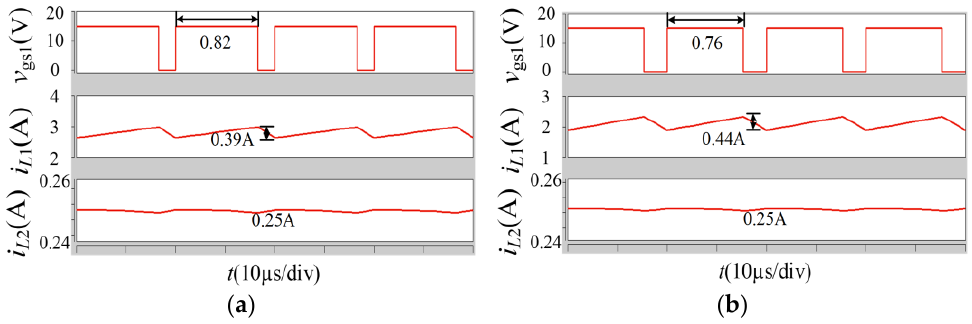
Figure 10. The stable simulation waveforms of i L1 , i L2 in step-up mode: ( a ) V 2 = 36 V; ( b ) V 2 = 48 V.